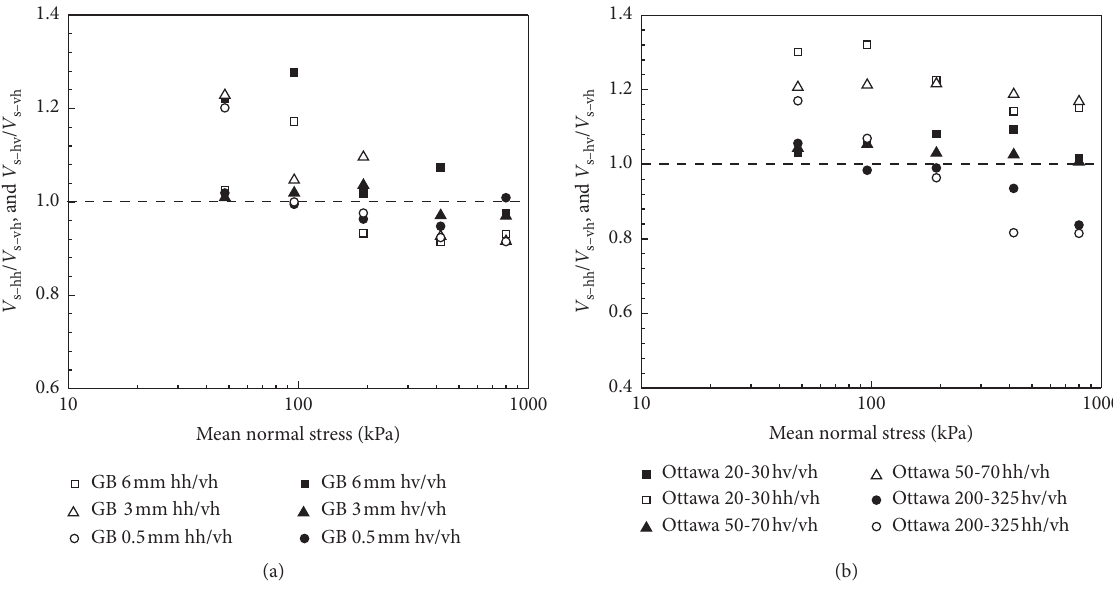
Figure 5: Anisotropic stress-induced anisotropy during unloading: (a) glass beads samples; (b) Ottawa sand samples.